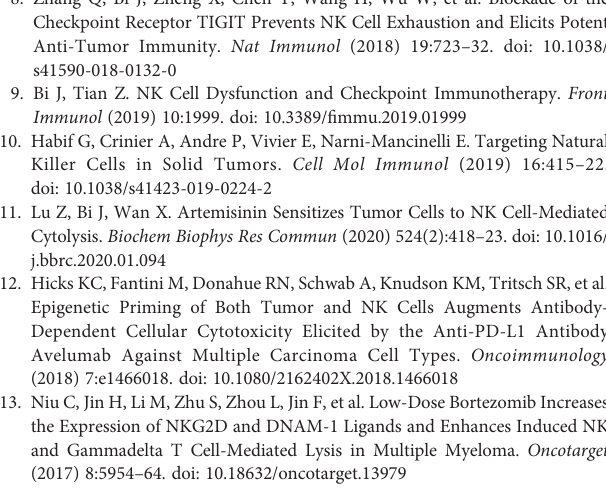
Supplementary Figure 1 | (A – D) real-time primary human NK cell cytolysis using the REAL-TIME Cell Analyzer (RTCA); (E – I) Median fl uorescence intensity of surface activating receptors on NK(YTS) and Tumor cells. (J, K) Survival curves for panobinostat therapy in B16F10 and CT26 tumor models (n =7); (L – O) NK cell depletion ( D NK) oneday before tumorinoculation. Assessmentof micebody weight and Tumor images for (L, M) B16F10, (N, O) RMA-S tumor models. Supplementary Figure 2 | (A) Gating strategy for expanded primary human NK cells (B) Gating strategy for mice splenocyte-derived NK